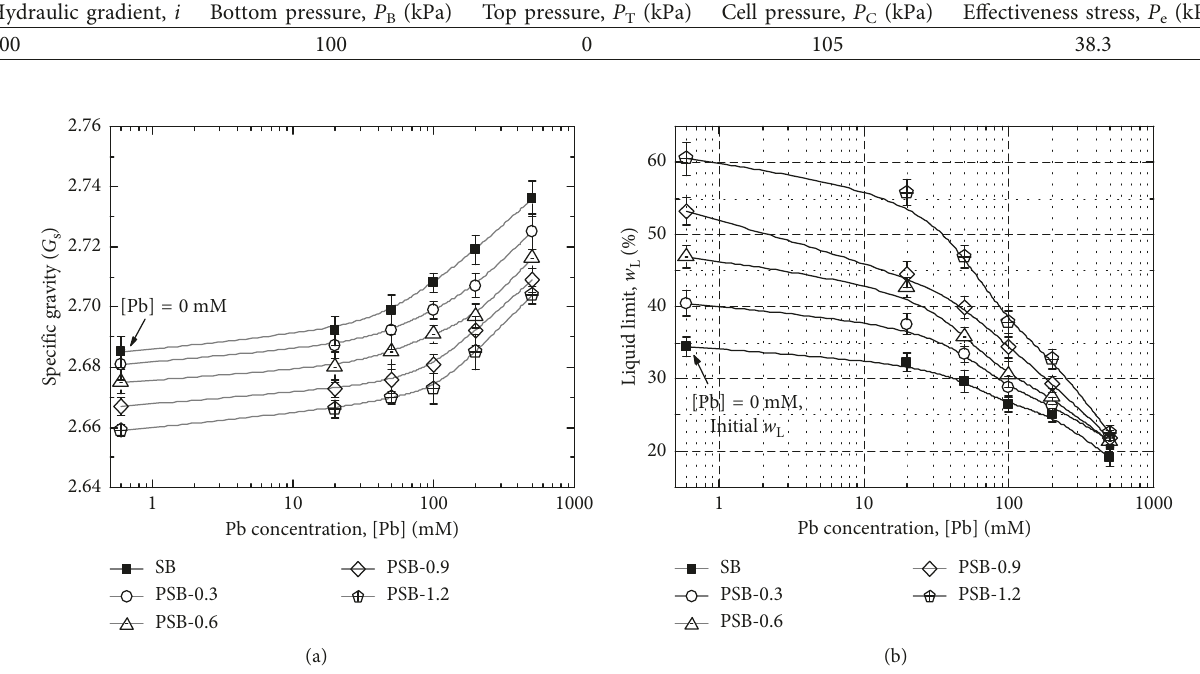
3; coefficient of variation (cid:31)